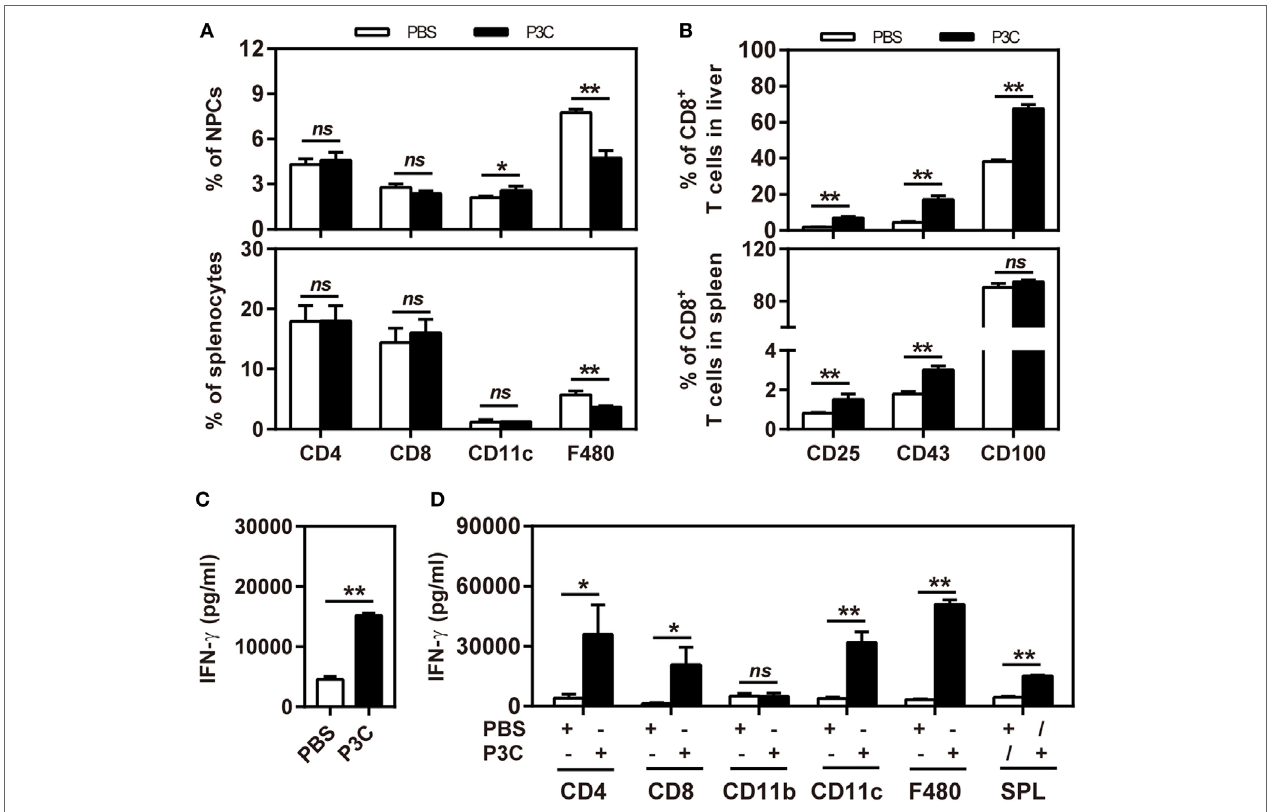
FigUre 4 | Application of P3C in vivo sustainably changes host immune status in the liver. (a,B) C57BL/6 mice were treated once with 20 µg of P3C or phosphate- buffered saline administered by intravenous (IV) injection. (a) Liver NPCs and splenocytes were separated at day 7 after IV injection of P3C. The composition of selected cell types was quantified by flow cytometry. (B) The surface markers CD25, CD43, and CD100 of CD8 + T cells from the liver and spleen were also detected by flow cytometry. (c) Murine splenocytes were isolated and stimulated with α CD3/CD28 for 48 h, and the supernatants were collected and subjected for detection of interferon gamma (IFN- γ ). (D) The CD4 + , CD8 + , CD11b + , CD11c + , and F4/80 + cells in the spleen were positively isolated by appropriate microbeads (purchased from Miltenyi Biotec GmbH). CD4 + , CD8 + , CD11b + , CD11c + , and F4/80 + cells were exchanged between two groups and cultured with α CD3/CD28 for 48 h, and unfractionated splenocytes were used as a control. The supernatants were collected and subjected to the ELISA assay of IFN- γ . Data were analyzed using an unpaired Student’s t test. Statistically significant differences between the groups are indicated: * P < 0.05; ** P <